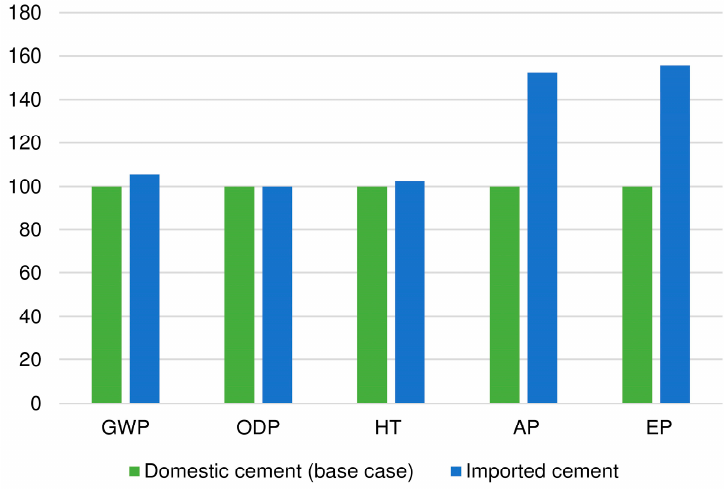
Figure 4. Normalized comparison of the total environmental impacts from two cases for concrete production; Base = 100 for cement produced in Iceland, Imported cement: cement imported from Germany.